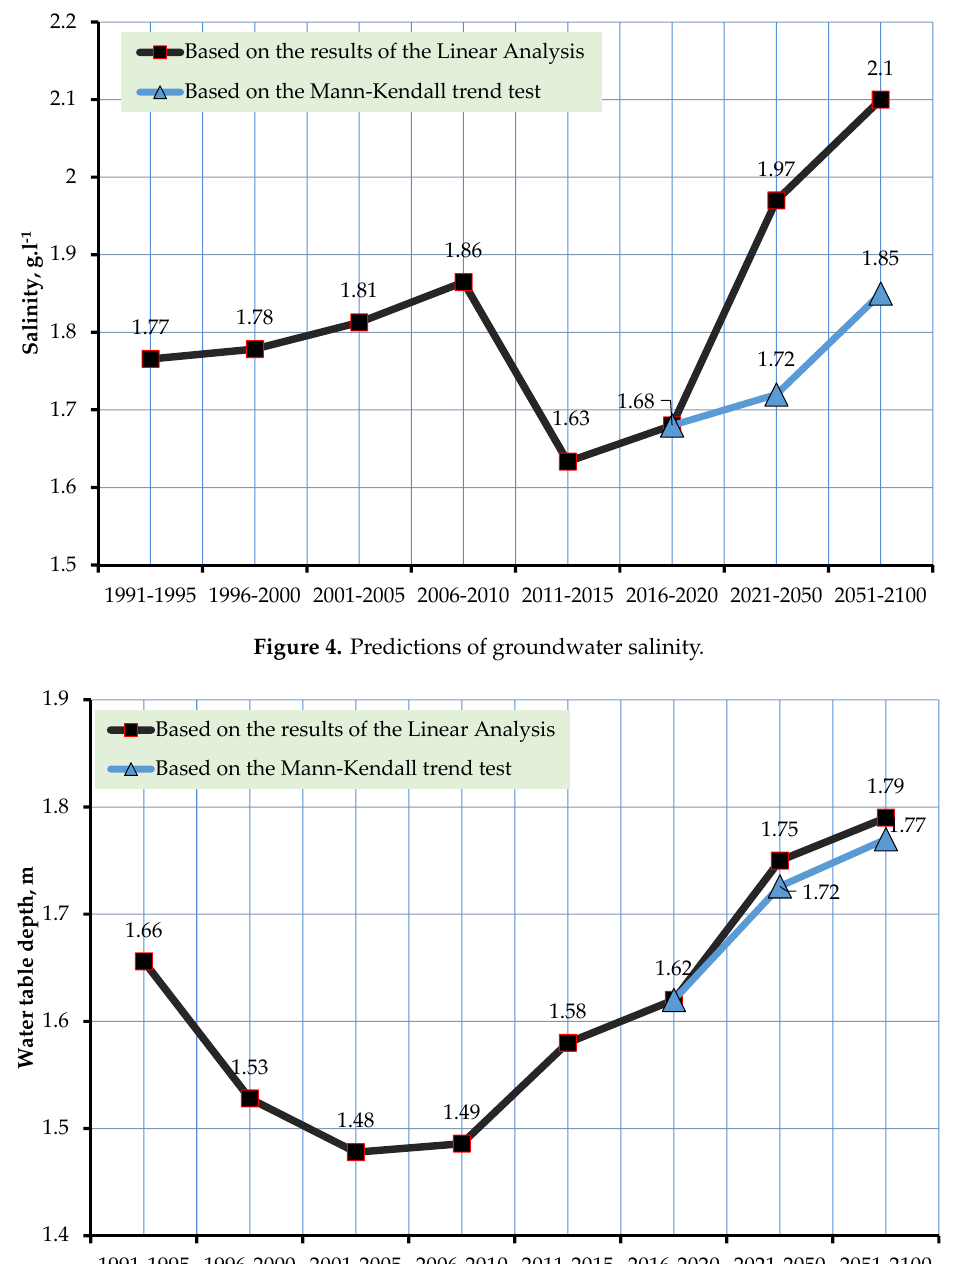
Figure 5. Predictions of water table depth.